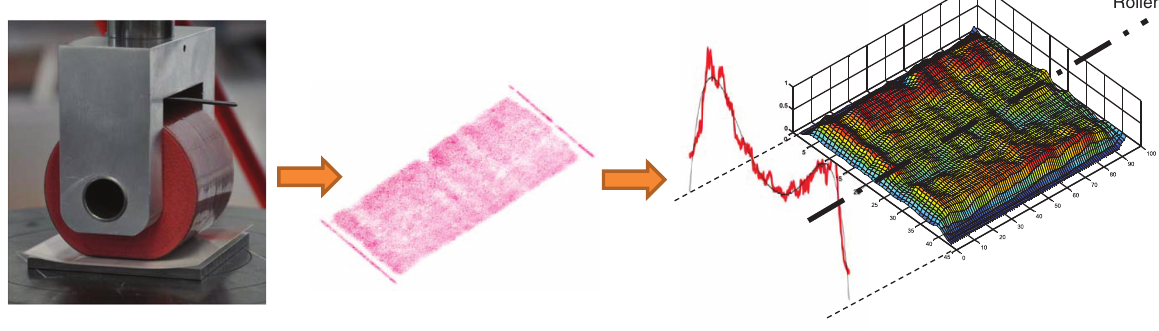
Figure 7 Normal pressure evaluation procedure for static compaction roller